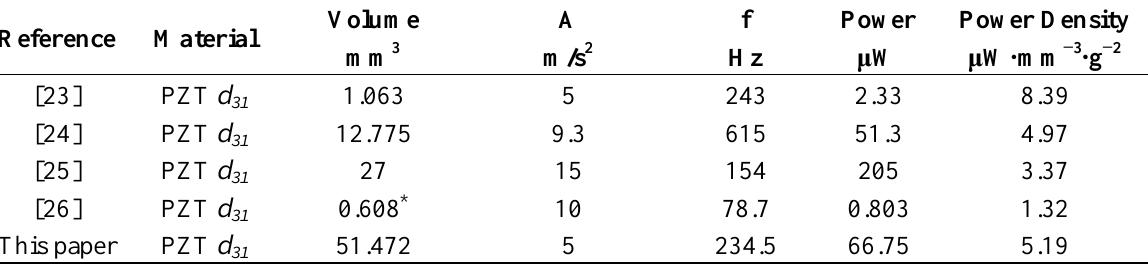
Table 2. Comparison of recent MEMS piezoelectric energy